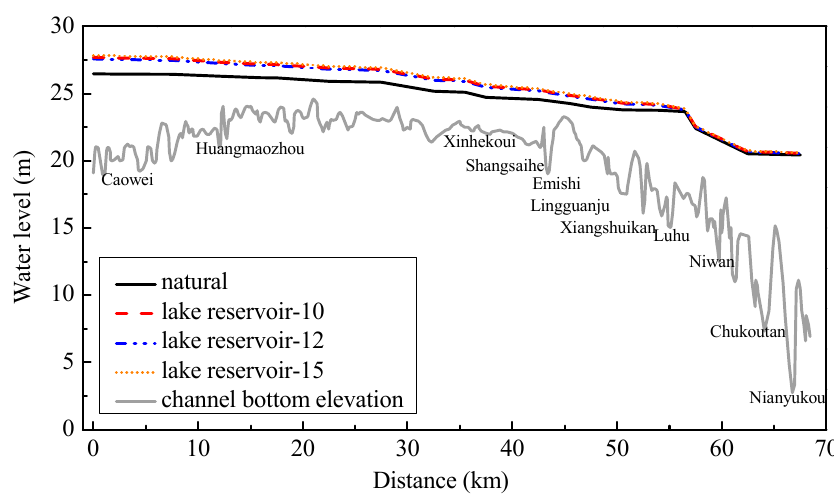
Figure 9. The distribution of the processing water elevation along the Dongting Lake channel.